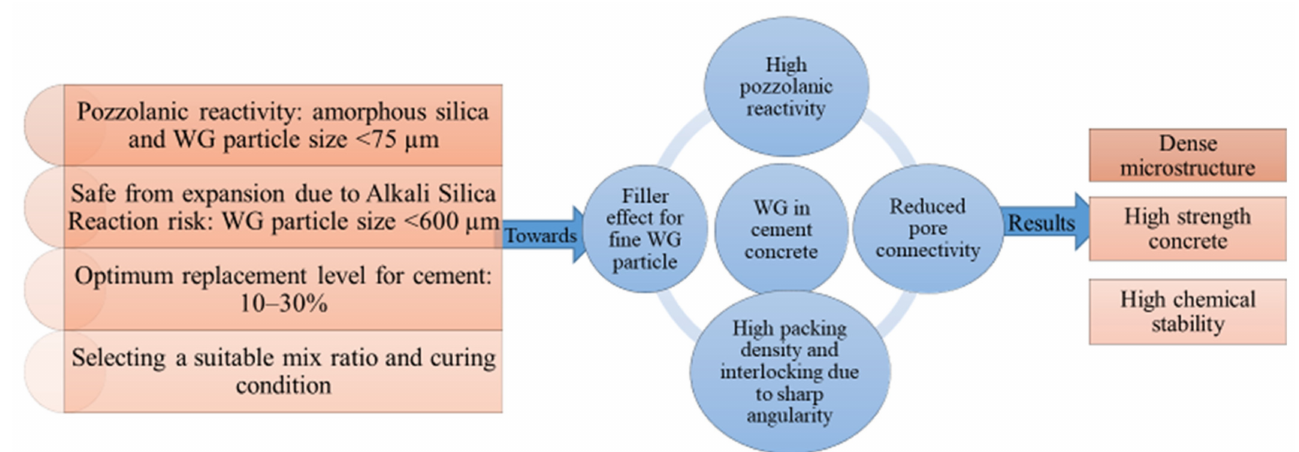
Figure 4. Selection guidelines and the optimum mixing parameters of WG to develop high-performance concrete